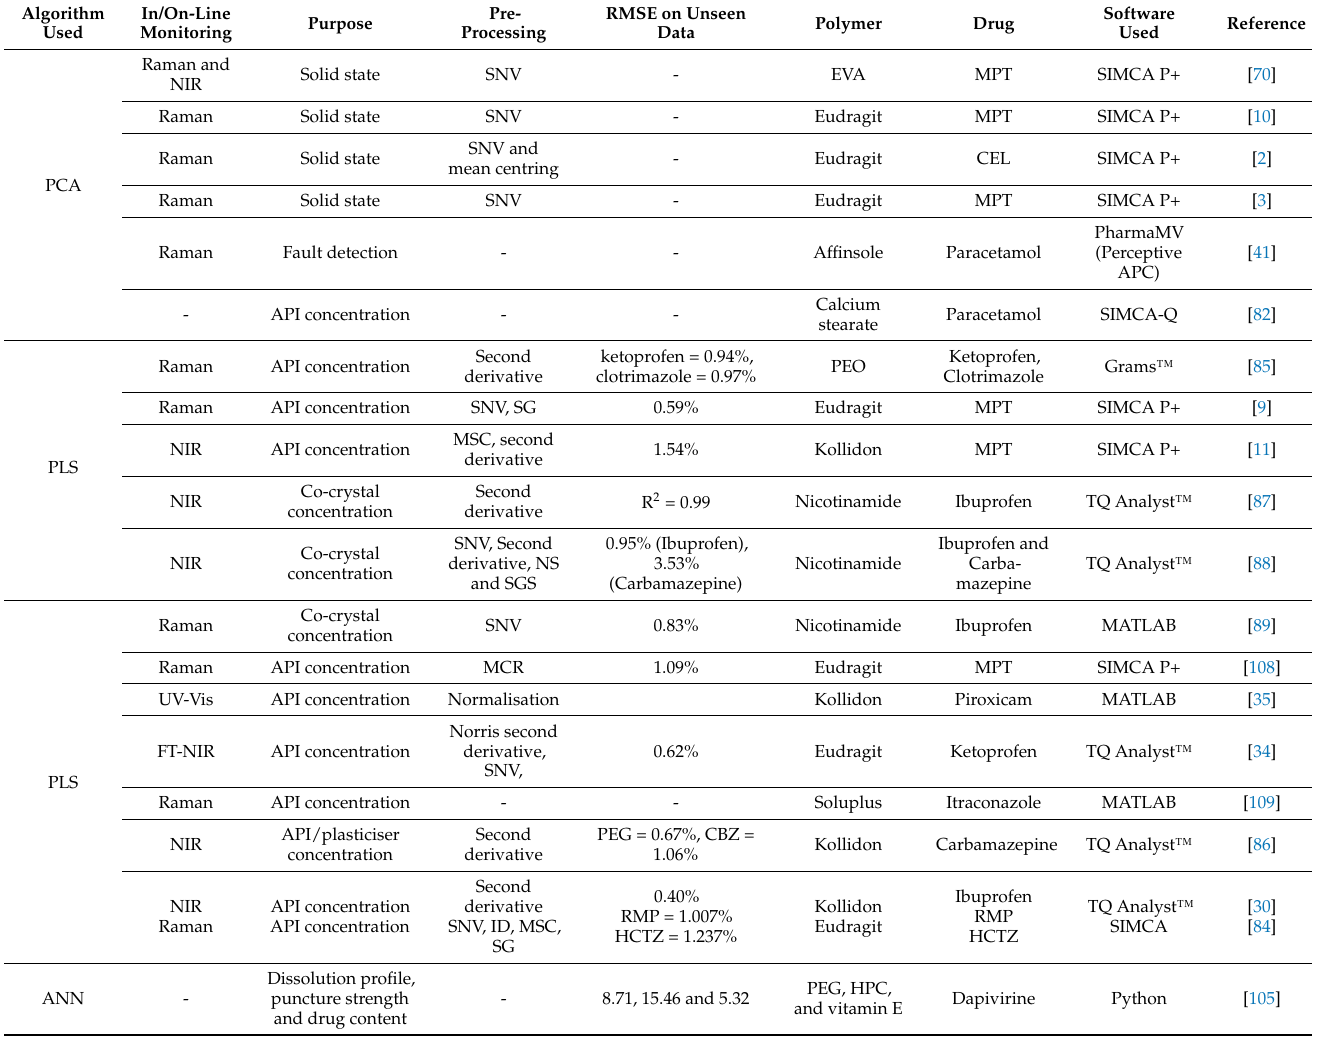
Table 3. Application of ML for pharmaceutical HME